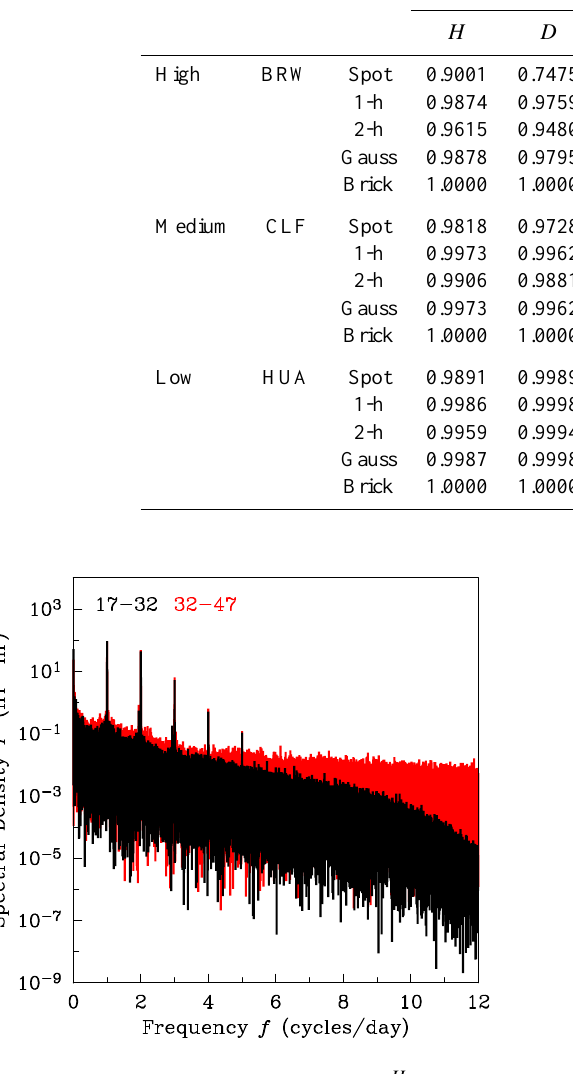
magnetic-field component and for each observatory. With- out exception, brick-wall (2-h) average-samples are the most (least) directly proportional to spot samples. Results for 1-h average-samples are relatively similar to those of both Gaus- sian and brick-wall